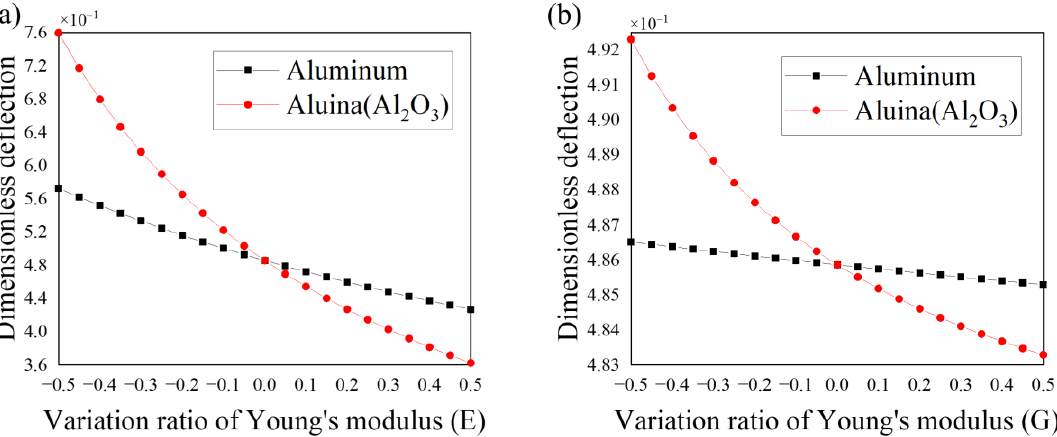
Figure 5. Variation of dimensionless deflection at mid-span of the beam: ( a ) Young’s modulus; ( b ) shear modulus.